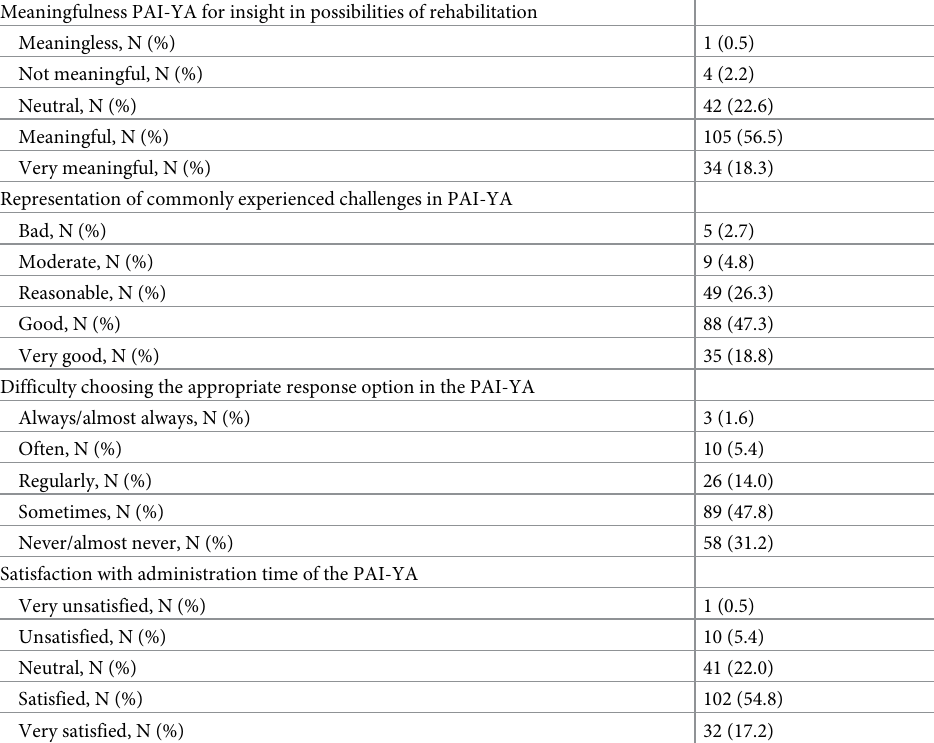
Table 5. Evaluation of the PAI-YA by young adults (N = 186). Meaningfulness PAI-YA for insight in possibilities of rehabilitation